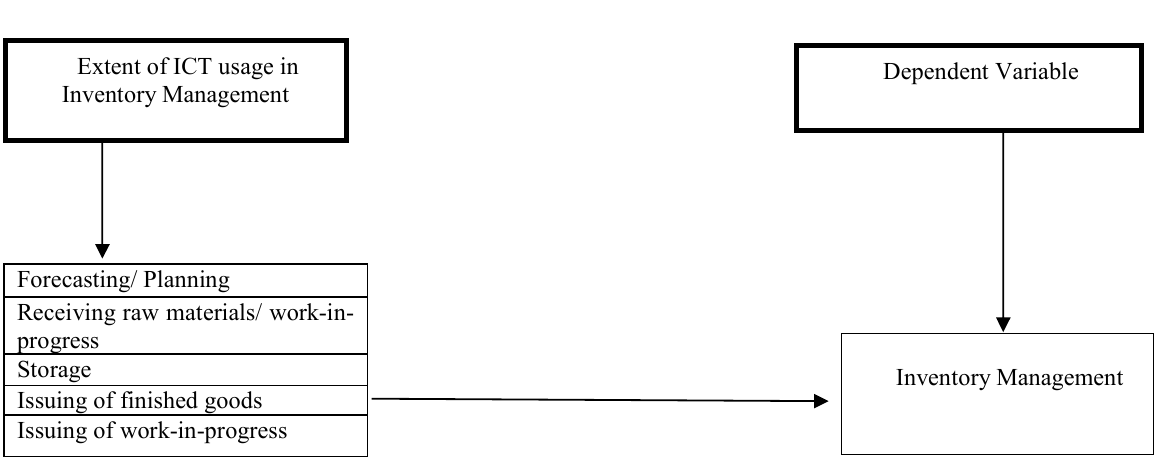
Fig. 1. Diagram showing the association between ICT, Revenue, Asset and Management of Inventory. Adopted from Odesola